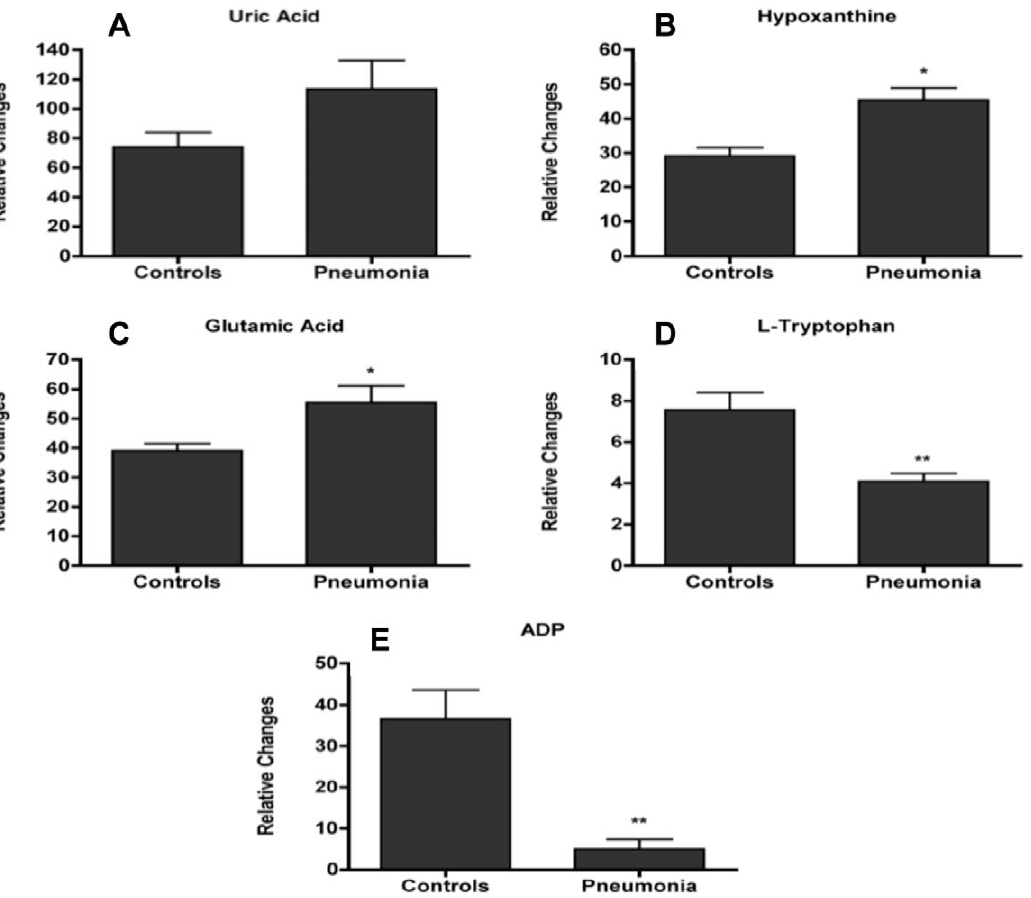
Figure 4. Relative changes of the plasma ions that were verified with tandem mass spectrometry. Data is represented as mean 6 SE of the peak areas extracted through the TOFMS data (with * representing p , 0.05 and ** representing p , 0.01). Unlike the urine samples, plasma samples do not require normalization to a particular metabolite since the volumes obtained are tightly controlled. Uric acid (Panel A) is upregulated in pneumonia plasma levels, although not statistically significant (p=0.119). This is in contrast to the urine findings. Hypoxanthine and glutamic acid levels in Panels B and C are significantly upregulated in pneumonia samples. On the other hand, L-tryptophan and adenosine-5 9 -diphosphate (ADP) in Panels D and E are significantly downregulated in pneumonia